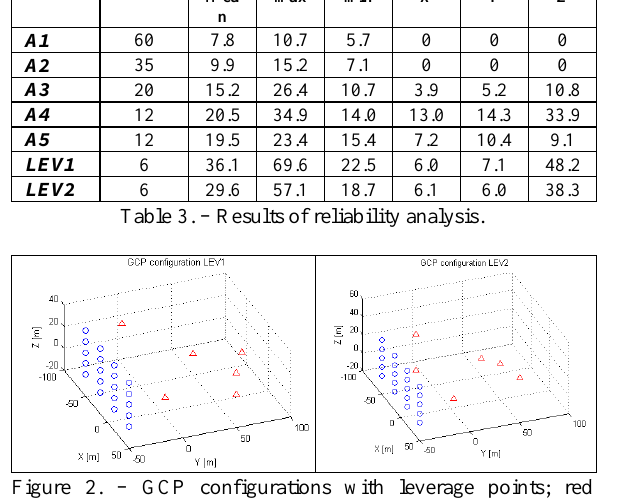
Figure 2. – GCP configurations with leverage points; red triangles are GCP, blue circle check points that are outside the bounding box of GCP to simulate a typical scenario in deformation